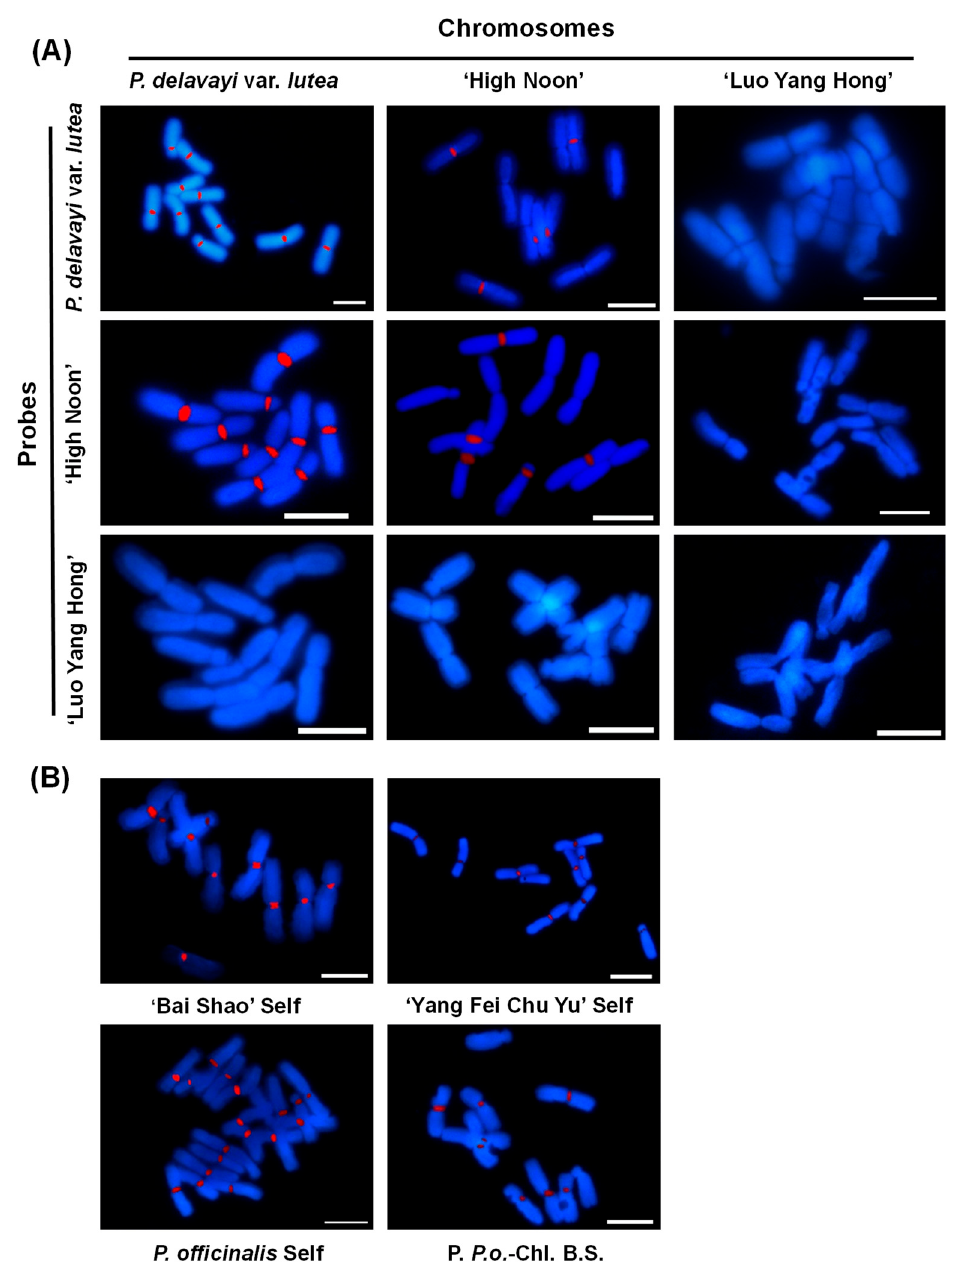
Figure 6. GISH analysis of mitotic chromosome pairings by pairwise hybridization in ( A ) sect. Moutan and ( B ) sect. Paeonia . Self refers to a situation where the material is used both as probe and chromosomal slide; P. P.o -Chl. B.S. means P. officinalis and ‘Bai Shao’ are used as probe and chromosomal slide, respectively. Bar = 10 μ m.